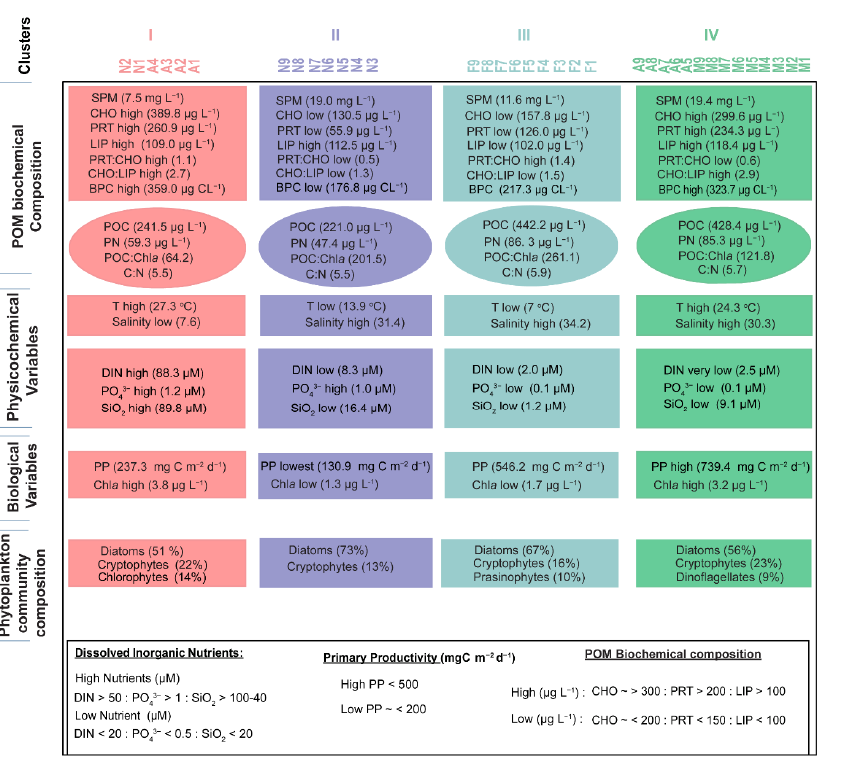
Figure 3. Distributions of the biogeochemical variables, as characterized by their median values in each cluster.